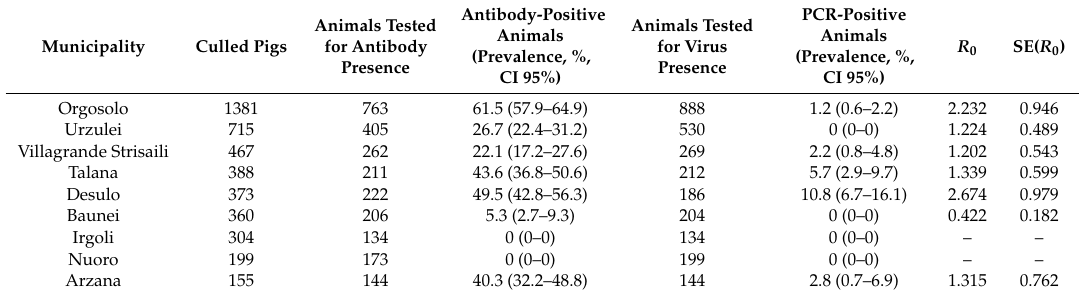
Table 2. Location, number of culled and tested free-ranging pigs, ASFV antibody and virus prevalence, and estimated basic reproduction number with the associated standard error